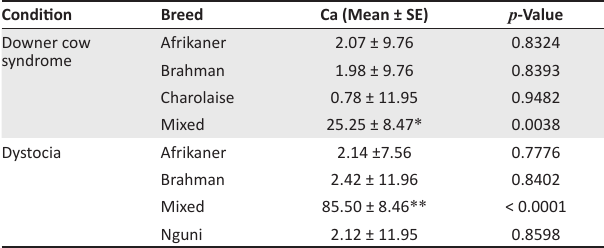
TABLE 2: Mean serum calcium (Ca) concentrations in different cow breeds experiencing reproductive conditions. Condition